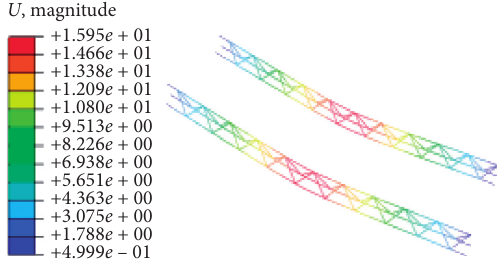
Figure 35: Cloud chart of the deformation of the truss bar under ultimate load.